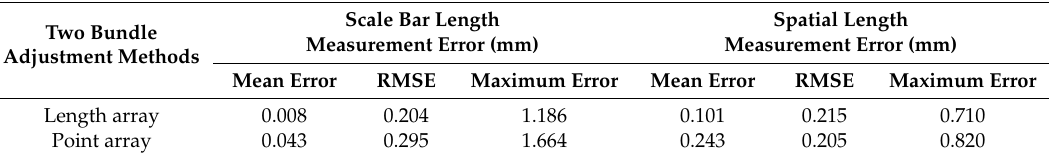
Figure 10. The point array and the camera stations. Table 5. Length measurement errors of the two methods.